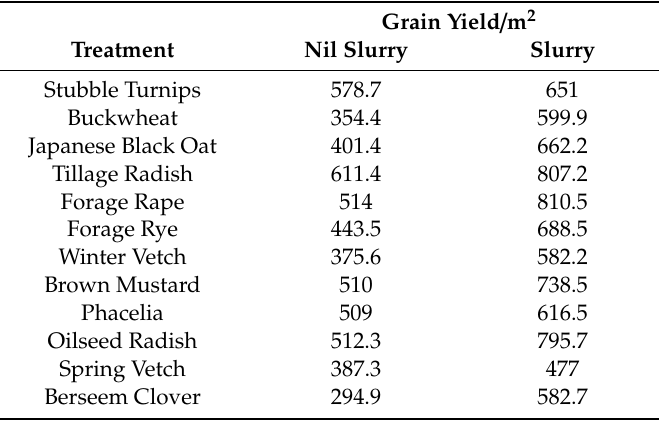
Table A5. Species grain yield in response to